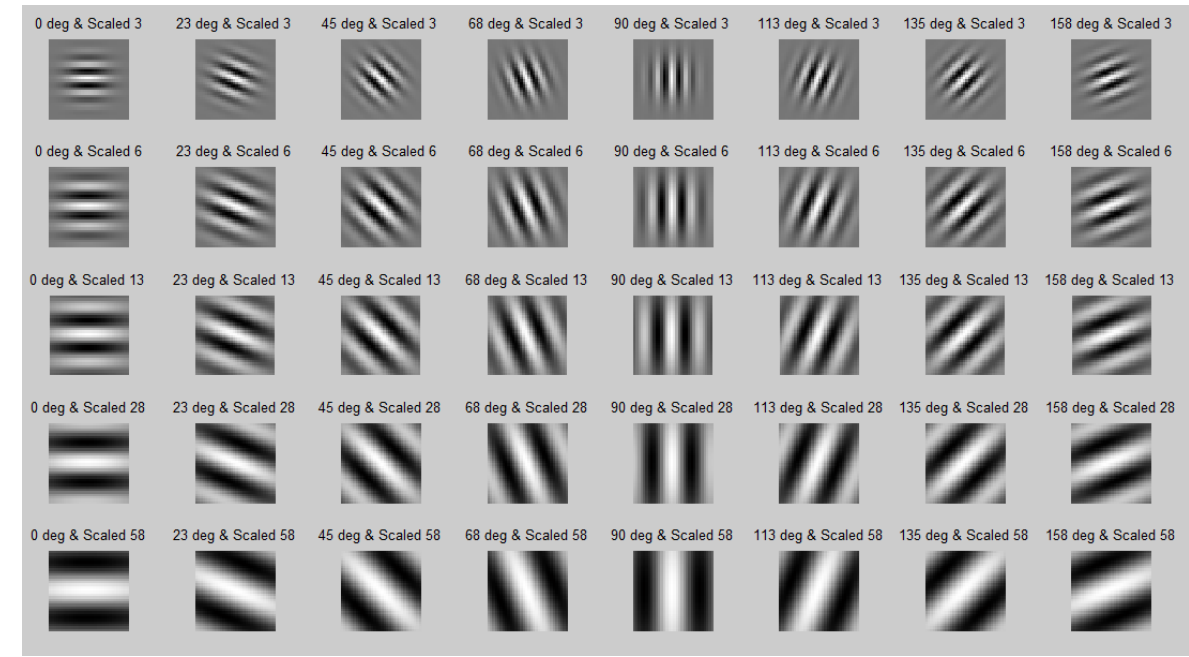
Figure 3. A two-dimensional Gabor filter with eight orientations and five scales [31].